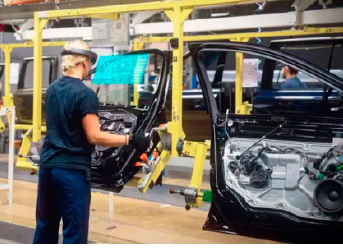
Figure 23. Assembly with AR.